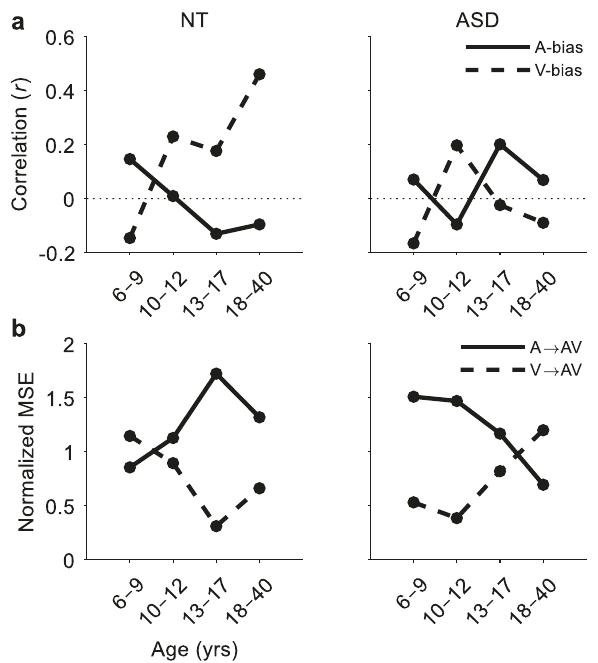
Fig. 5 Age-related changes in sensory dominance. a Sensory dominance was examined by measuring the performance of Model 1A (auditory bias, solid trace) and Model 1V (visual bias, dotted trace) with the probability of a sensory-speci fi c bias p set to 1 (Eq. 8). The ability of each model to predict empirical bene fi ts was assessed within each age group based on the Pearson correlation coef fi cient. b Modality switch effects for AV trials separated by trials preceded by A-stimuli (solid trace) and V-stimuli (dotted trace). MSEs were quanti fi ed by the area between the CDFs of the switch and repeat trials and normalised by the grouped V/A → AV ( β = 0.002, SE = 0.0002, p = 1 × 10 − 24 , BF 01 = 7 × 10 − 21 ) and, contrary to previous work 63 , were reduced in individuals with ASD compared to NT individuals ( β = − 0.012, SE = 0.002, p = 4 × 10 − 7 , BF 01 = 9 × 10 − 5 ). Compared to multisensory trials, MSEs were larger on both auditory trials ( β = 0.048, SE = 0.003, p = 2 × 10 − 59 , BF 01 = 3 × 10 − 59 ) and visual trials ( β = 0.037, SE = 0.003, p = 7 × 10 − 38 , BF 01 = 3 × 10 − 59 ). Follow-up permu- tation tests and Bayes factor analyses revealed that MSEs were only reduced in the adolescent ASD group when switching from auditory to visual stimuli ( t (56) = 3.63, p = 0.001, Hedge ’ s g = 0.94, 95CI [0.46, 1.52], BF 01 = 0.02; Fig. 6a). A more detailed